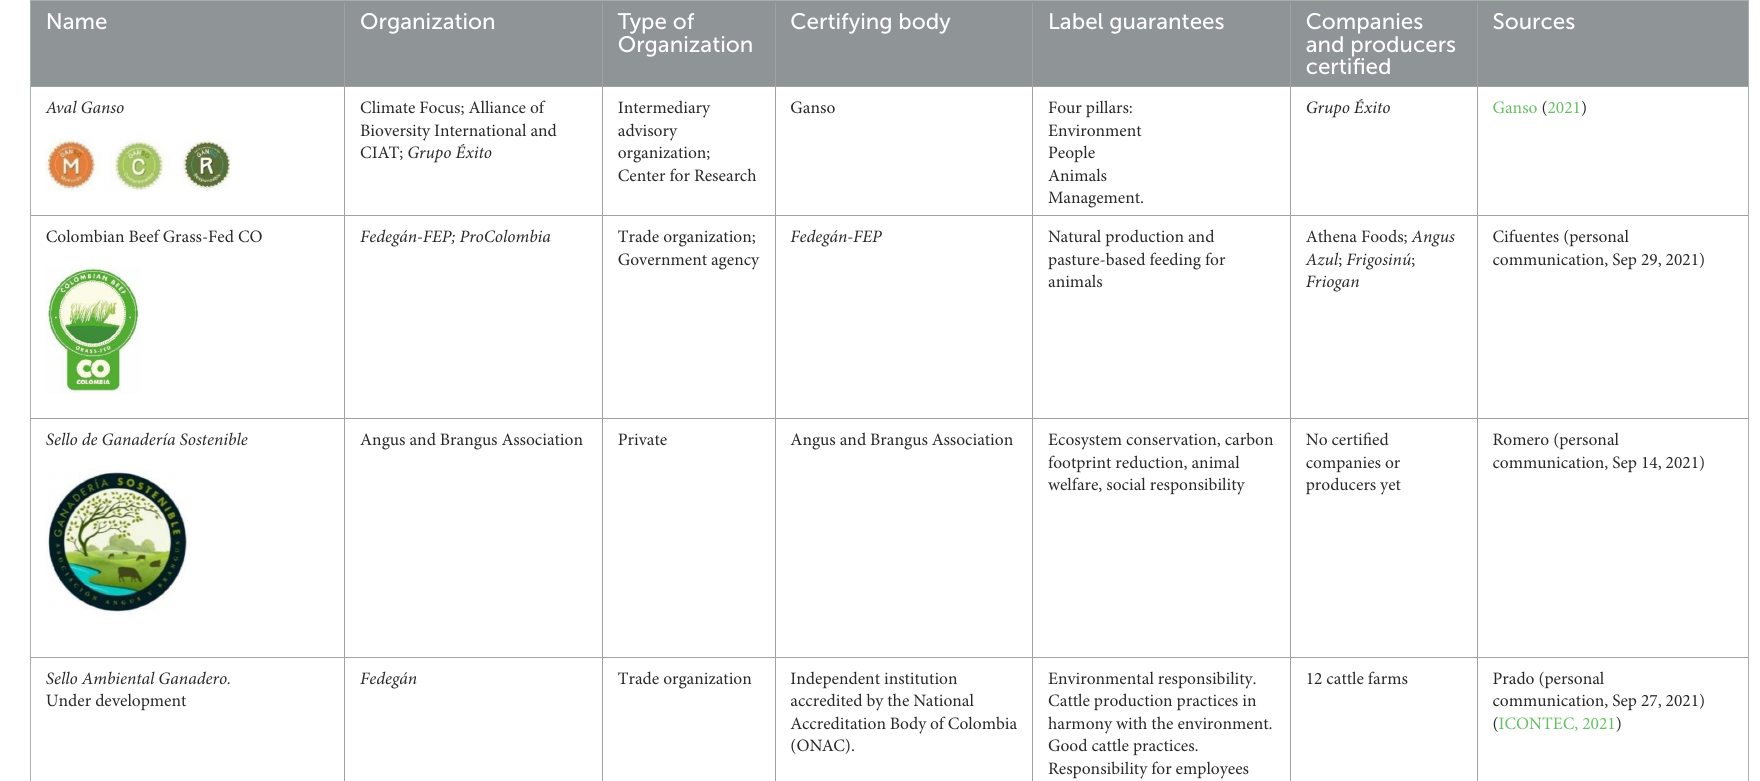
TABLE 5 Characteristics of Colombian sustainability